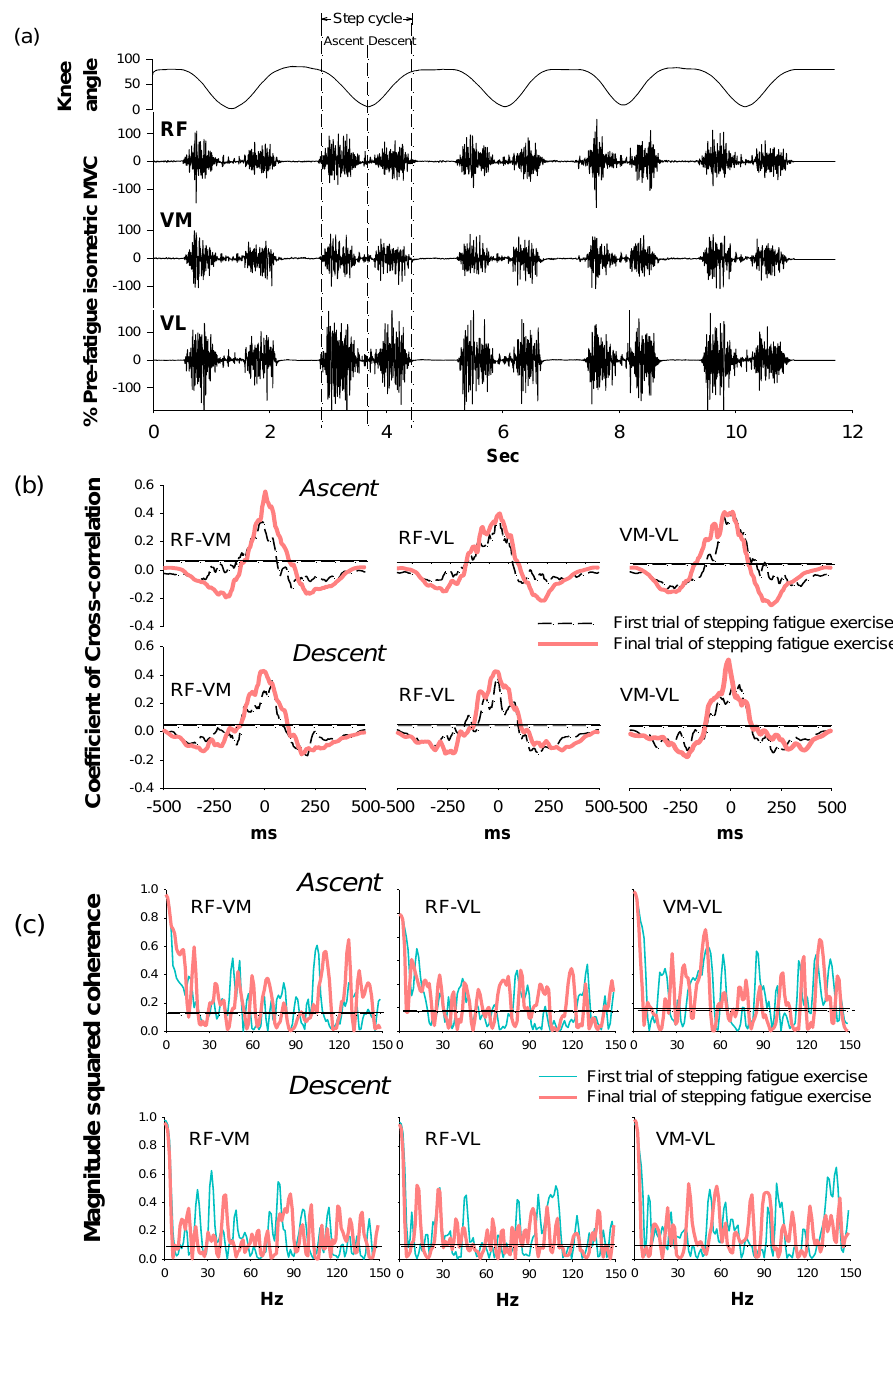
Figure 3. EMG signals from knee muscles of rectus femoris (RF), vastus medialis (VM) and vastus lateralis (VL) during stepping exercise and the corresponding changes in the range of motion of the knee joint from one representative subject ( a ). The diagram of cross-correlation ( b ) and coherence ( c ) for three muscle pairs of RF-VM, RF-VL and VM-VL during the first (bold dash line) and final trial (bold solid line) of stepping exercise. The horizontal lines in (b) and (c) are the averaged 95% confident intervals for the first (thin dash line) and final trial (thin solid line) of stepping